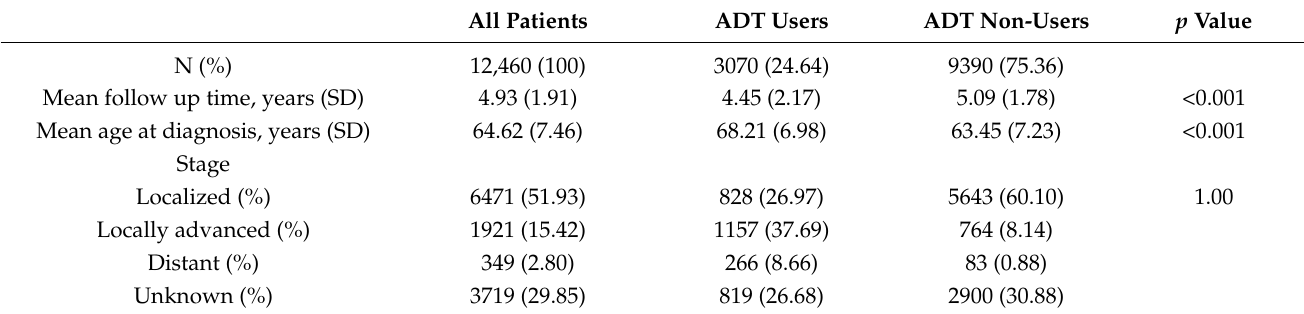
Table 1. Baseline characteristics of men with prostate cancer, separated according to ADT use. All Patients